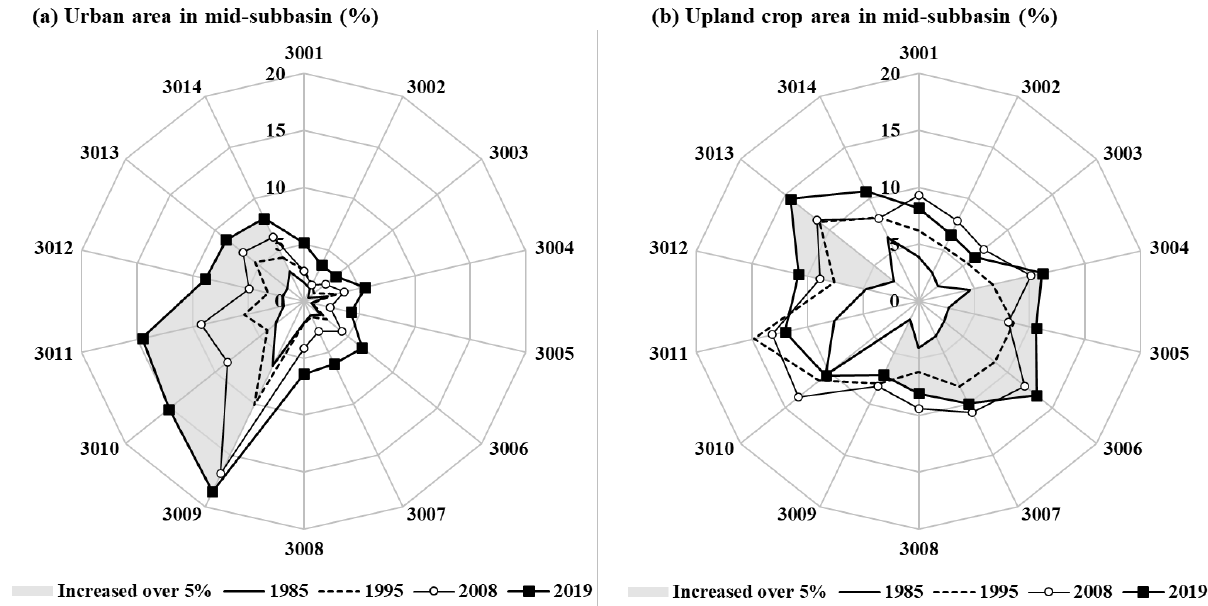
Figure 3. Area changes in the mid-subbasins from 1985 to 2019, ( a ) urban area (%) and ( b ) upland crop area (%). Table 2. Land-use occupation in the GRB.